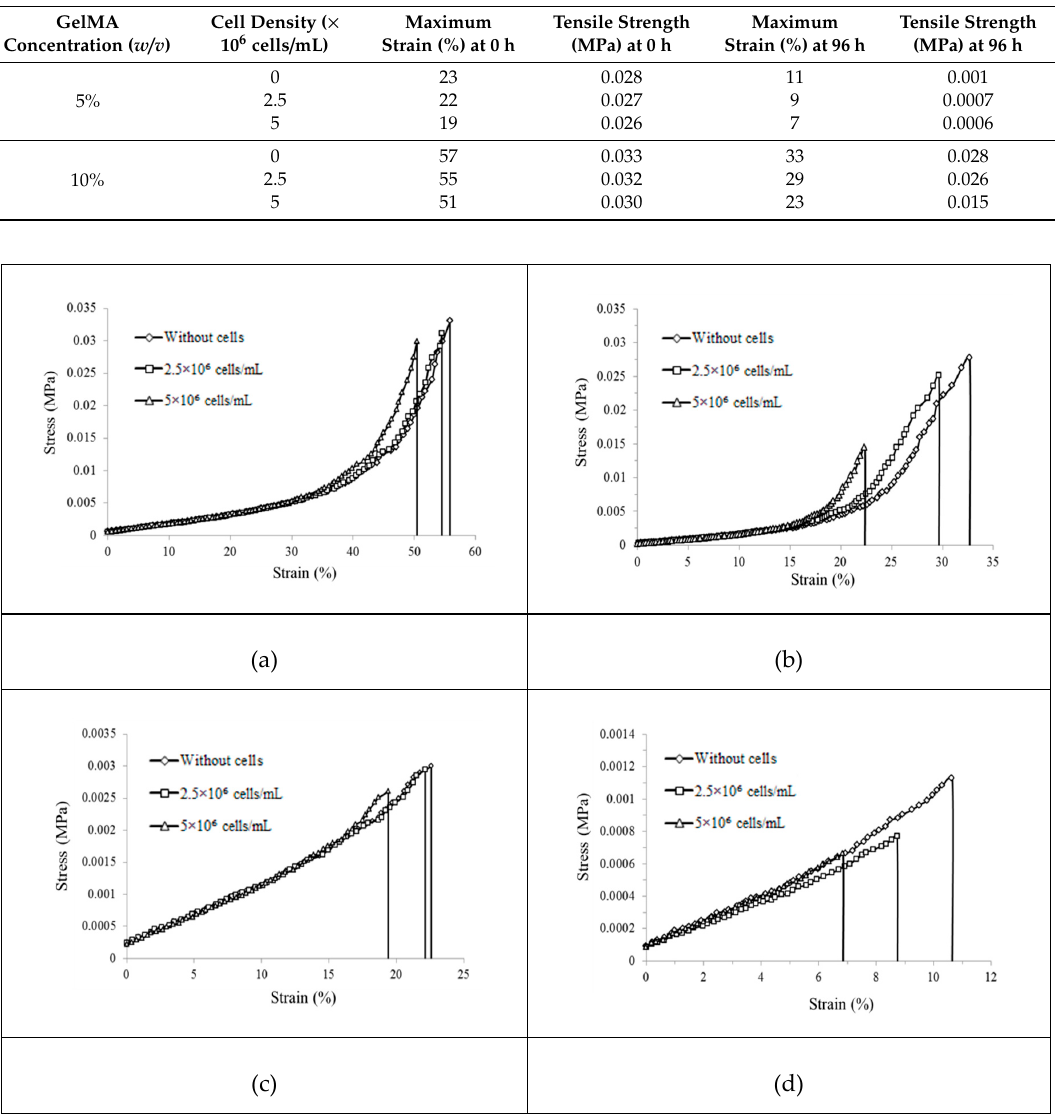
Table 1. Summarized results of mechanical testing of cell-encapsulated GelMA samples.